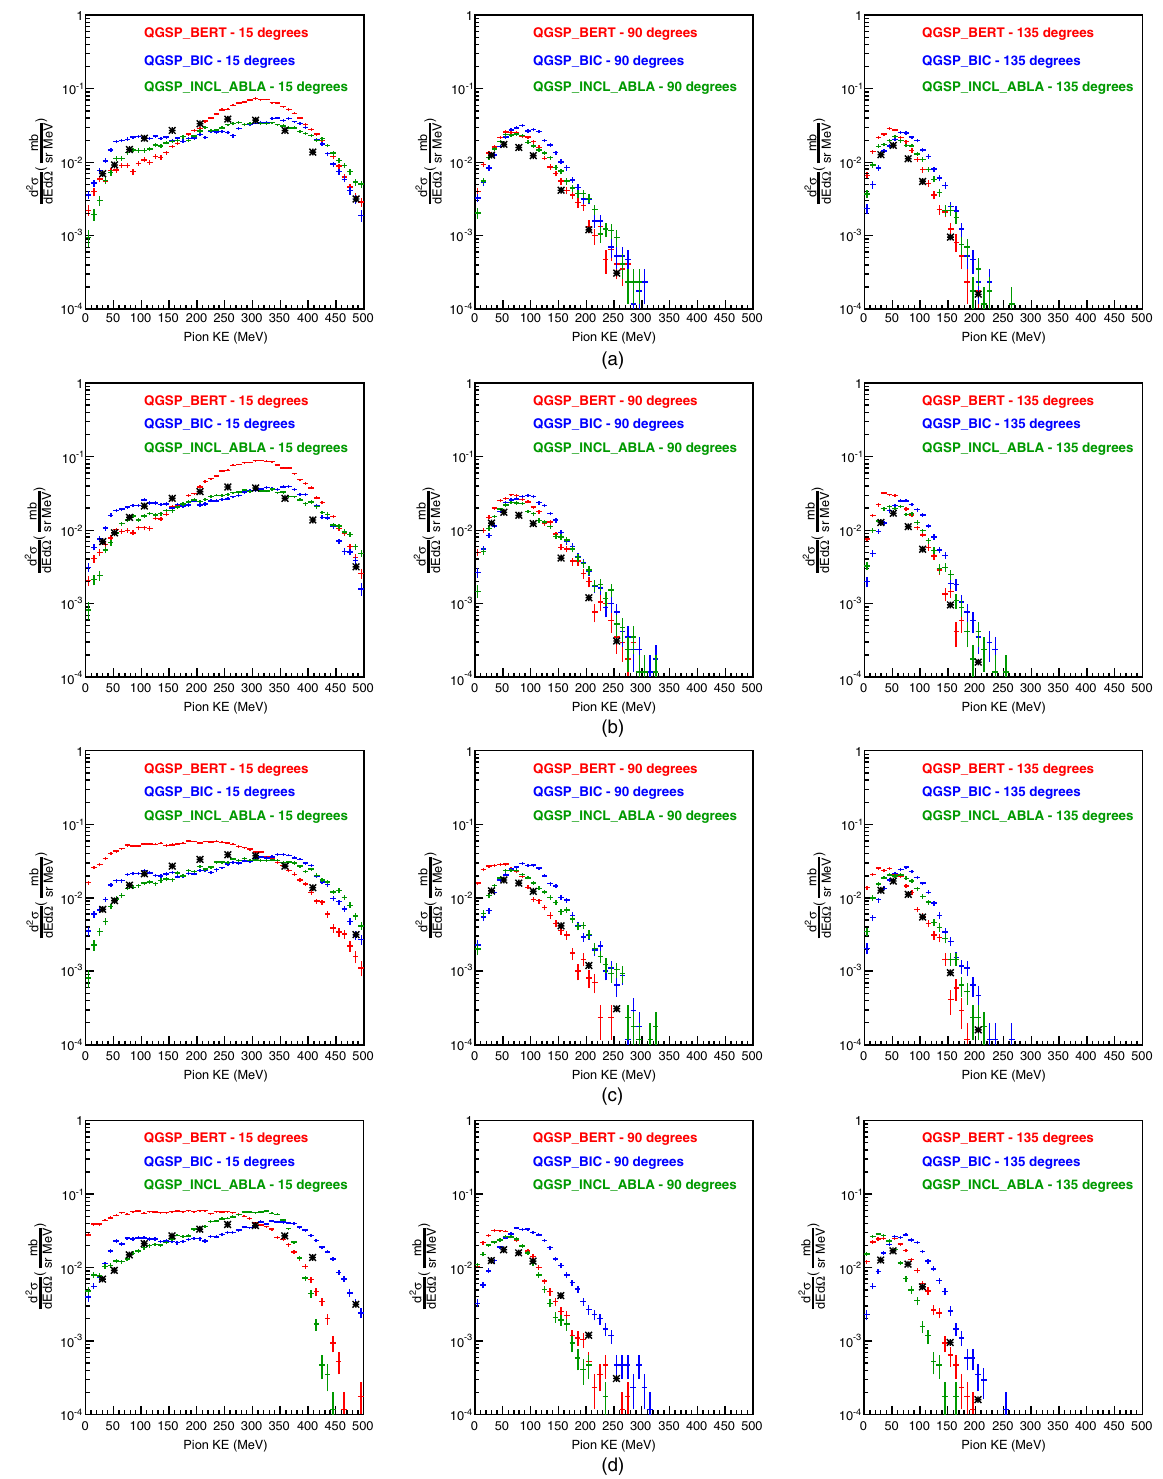
FIG. 1. Double differential cross-section predictions with the last four G EANT 4 versions for positive pion production. Three physics packages (QGSP-BERT, QGSP-BIC, QGSP-INCL-ABLA) are compared with experimental data. (a) Pion production double differential cross section using the G EANT 4 version geant4.9.3.p02. (b) Pion production double differential cross section using the G EANT 4 version geant4.9.4.p04. (c) Pion production double differential cross section using the G EANT 4 version geant4.9.5.p02. (d) Pion production double differential cross section using the G EANT 4 version